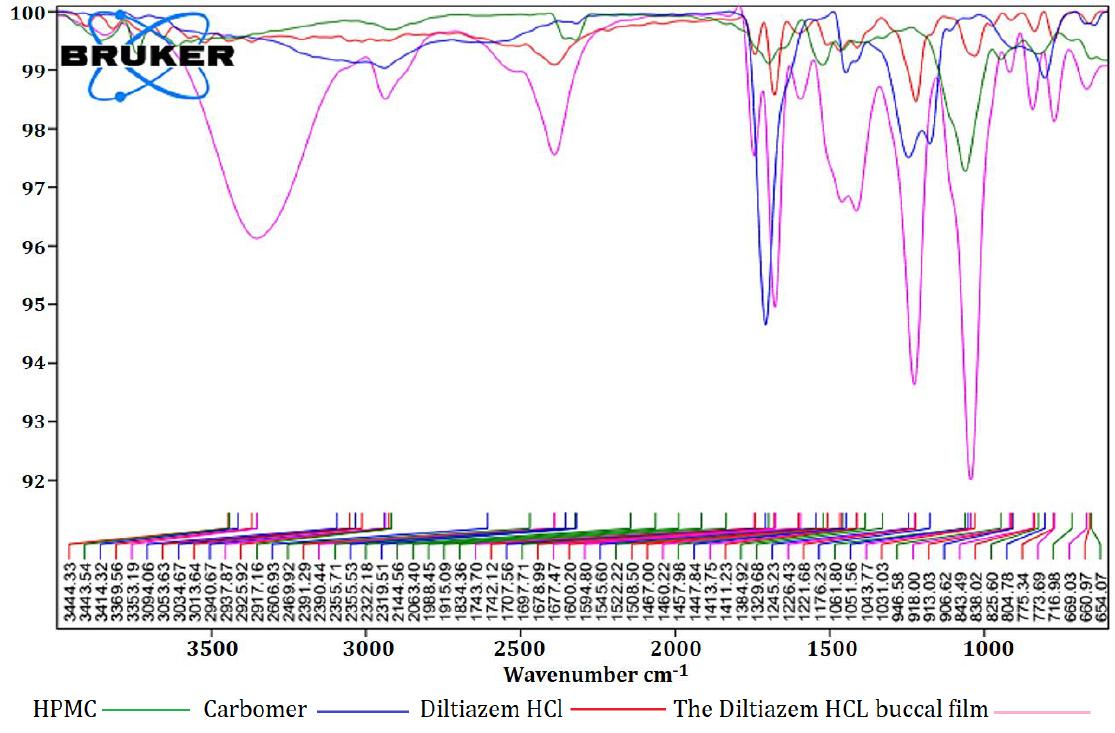
Figure 4.The FTIR result of optimum formula, pure diltiazem HCl, HPMC, and carbomer Table IV. The dissolution parameters obtained from DDSolver program Dissolution